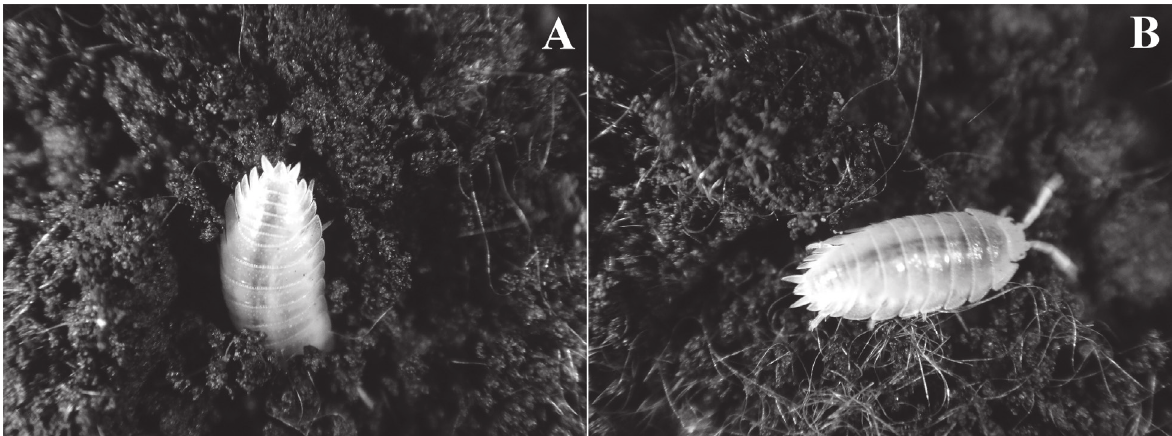
Figure 4 . Trichorhina kaingangi n. sp.. A, B, specimens from Gruta Ermida Paiol do Alto, Adrianópolis,